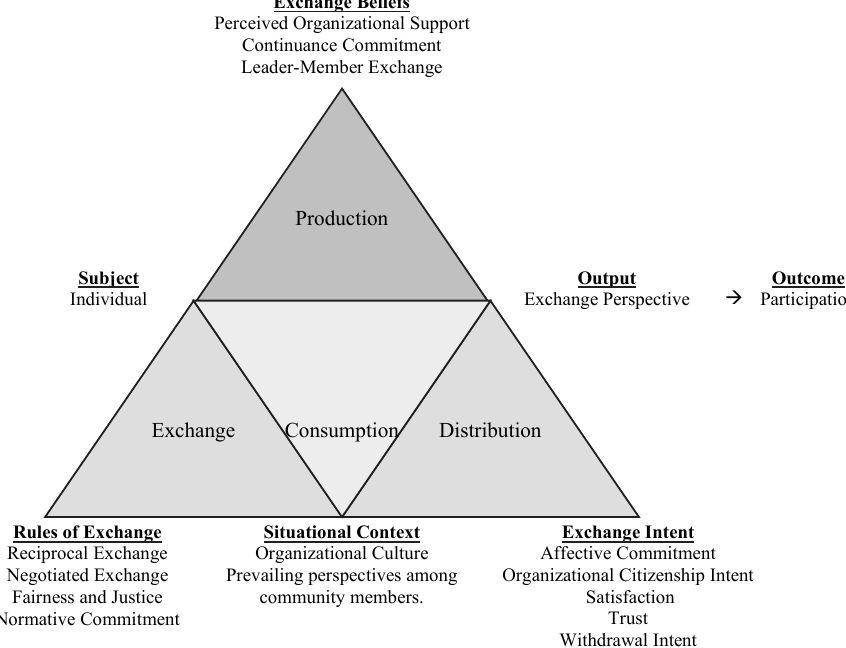
Fig. 2. The Exchange Perspective Formulation Activity